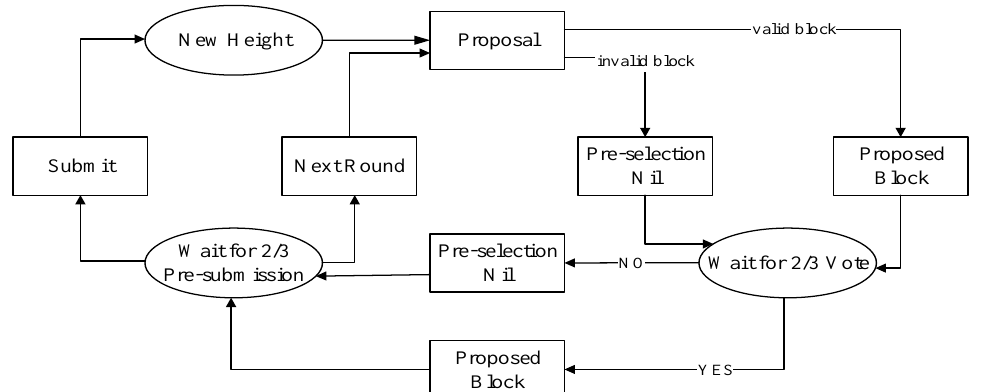
N Figure 2. The relationship between nodes on the blockchain system. The blockchain-based E-bidding system is designed as a consortium chain, which ensures that the traceable data on the chain cannot be tampered with. Moreover, the con- sensus mechanism of the consortium chain can tolerate node error rates up to one-third, which includes arbitrary node offline and malicious behaviors. Under this mechanism,